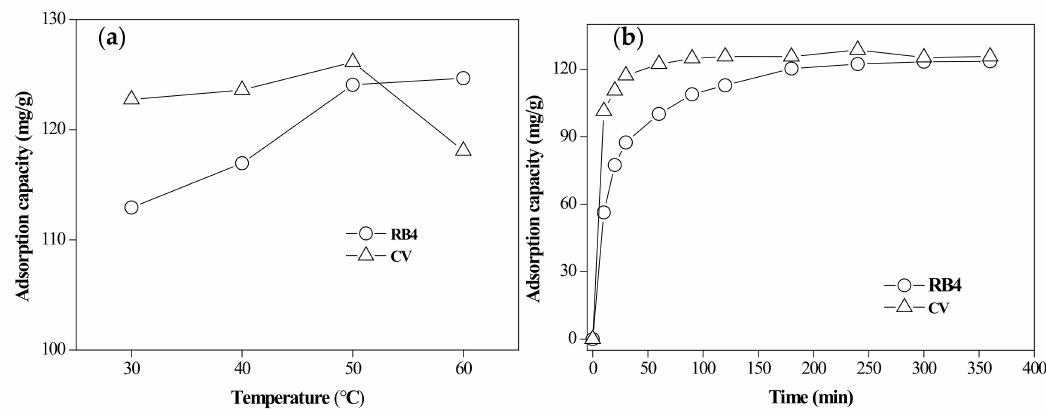
Figure 7. ( a ) E ff ect of temperature on removing dyes; ( b ) e ff ect of contact time on removing